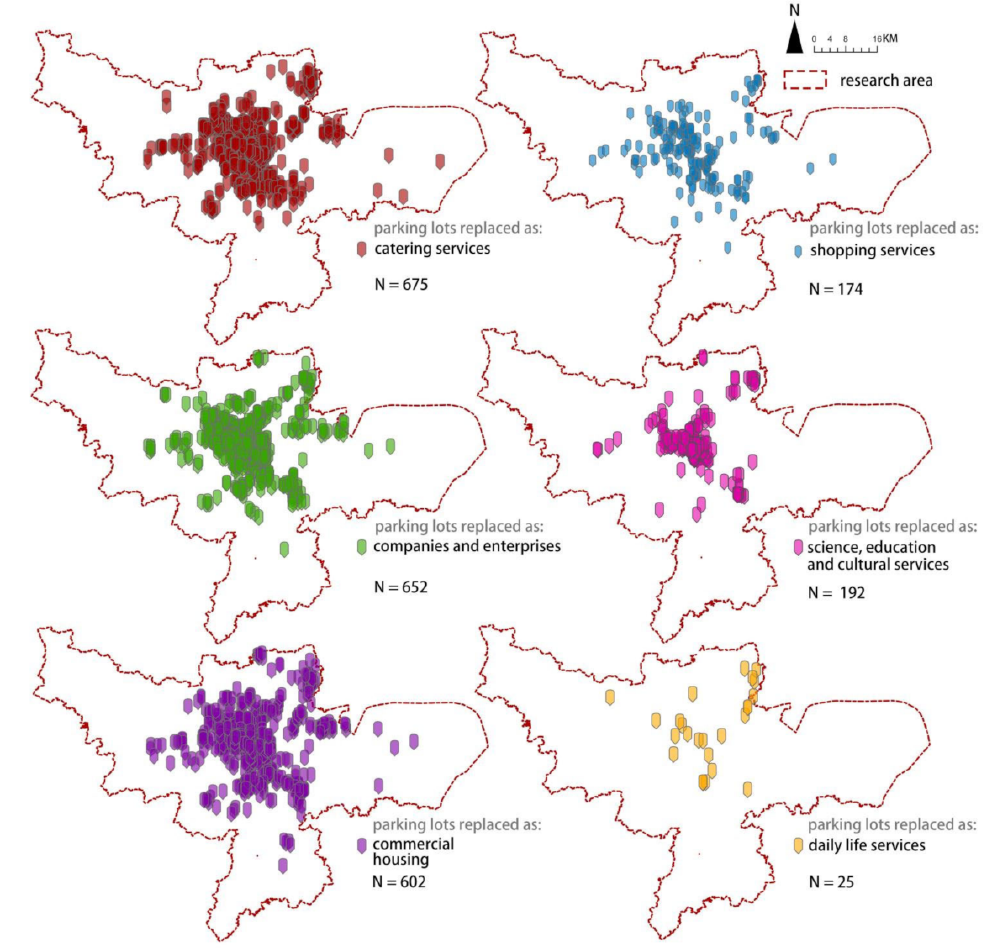
Figure 12. The results of function replacement of parking spaces according to the associate